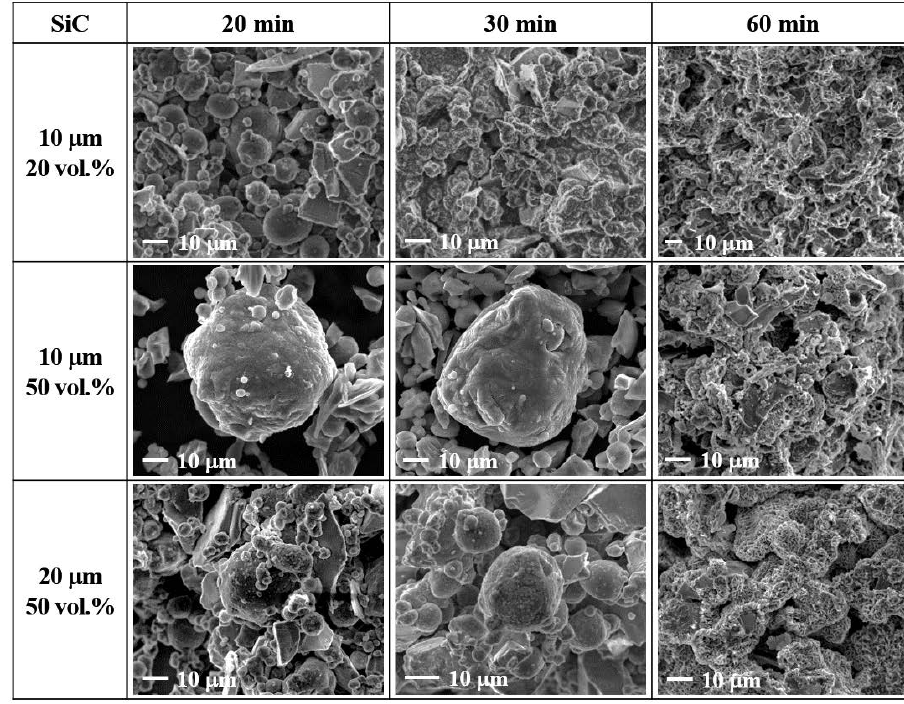
Figure 3. SEM images of SiC/6061Al composites obtained by heating at 650 °C for 20, 30, and 60 min.